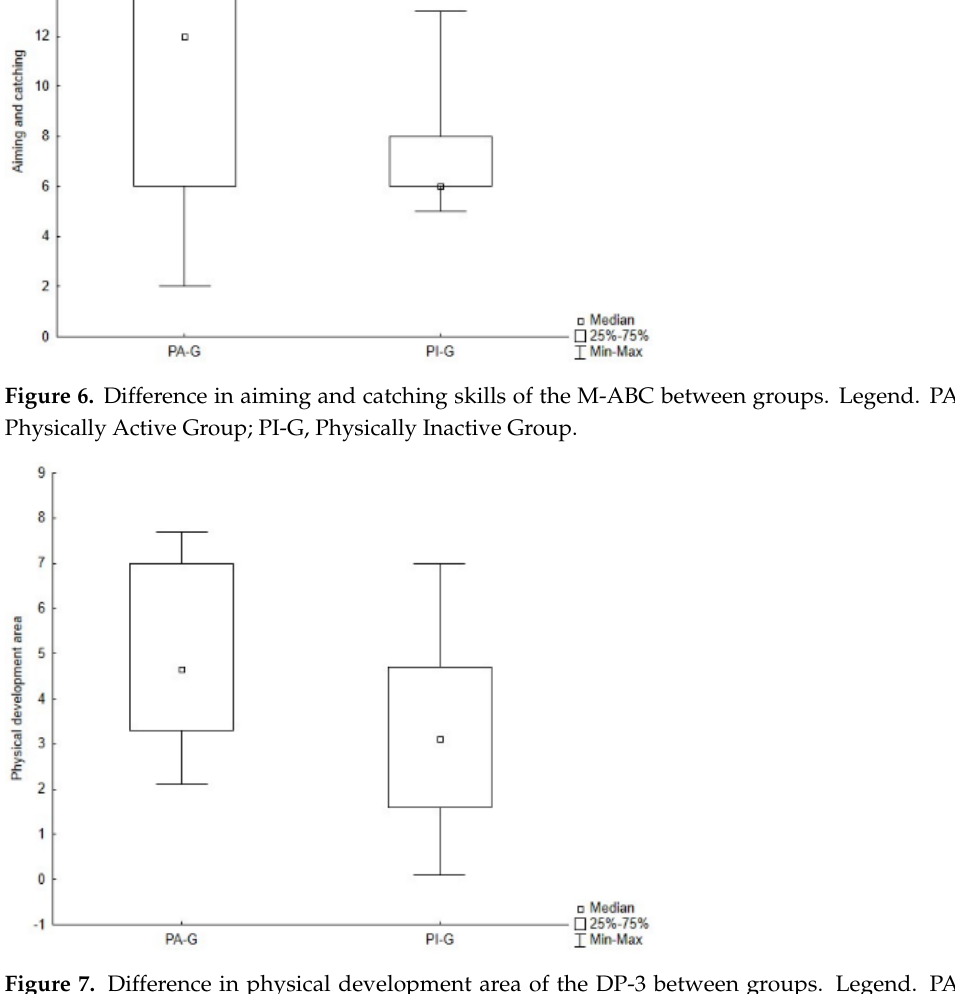
Figure 7. Difference in physical development area of the DP-3 between groups. Legend. PA-G, Physically Active Group; PI-G, Physically Inactive Group.